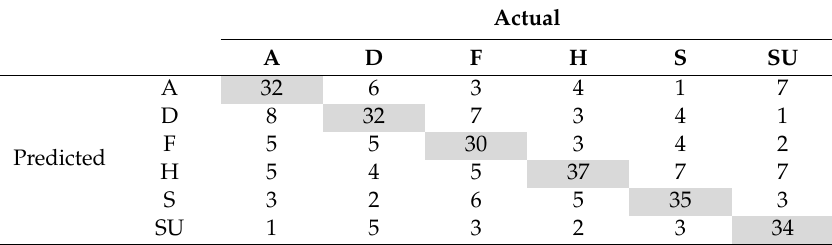
Table 7. Confusion matrix of the LBD group using the H 3 feature in PNN classification.